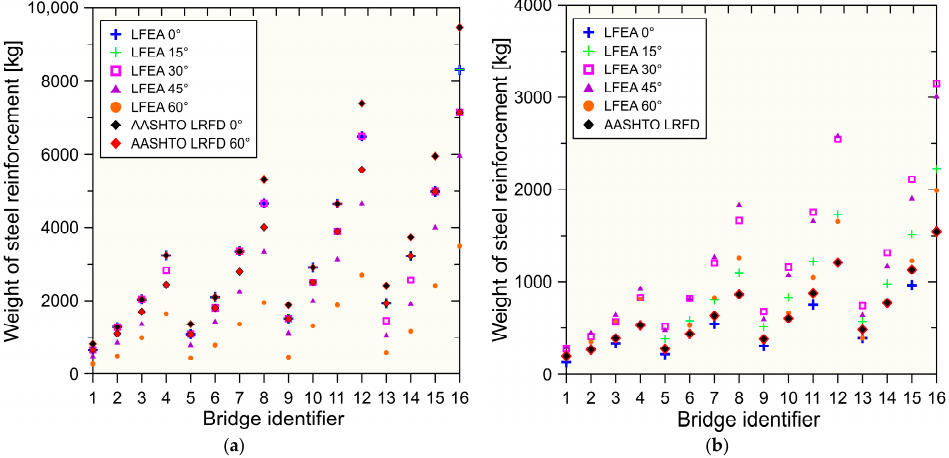
Figure 12. Weight (in kg) of steel reinforcement for bending moment. ( a ) Longitudinal reinforcement, and ( b ) transverse reinforcement, with bridge identifiers explained in Table 7.